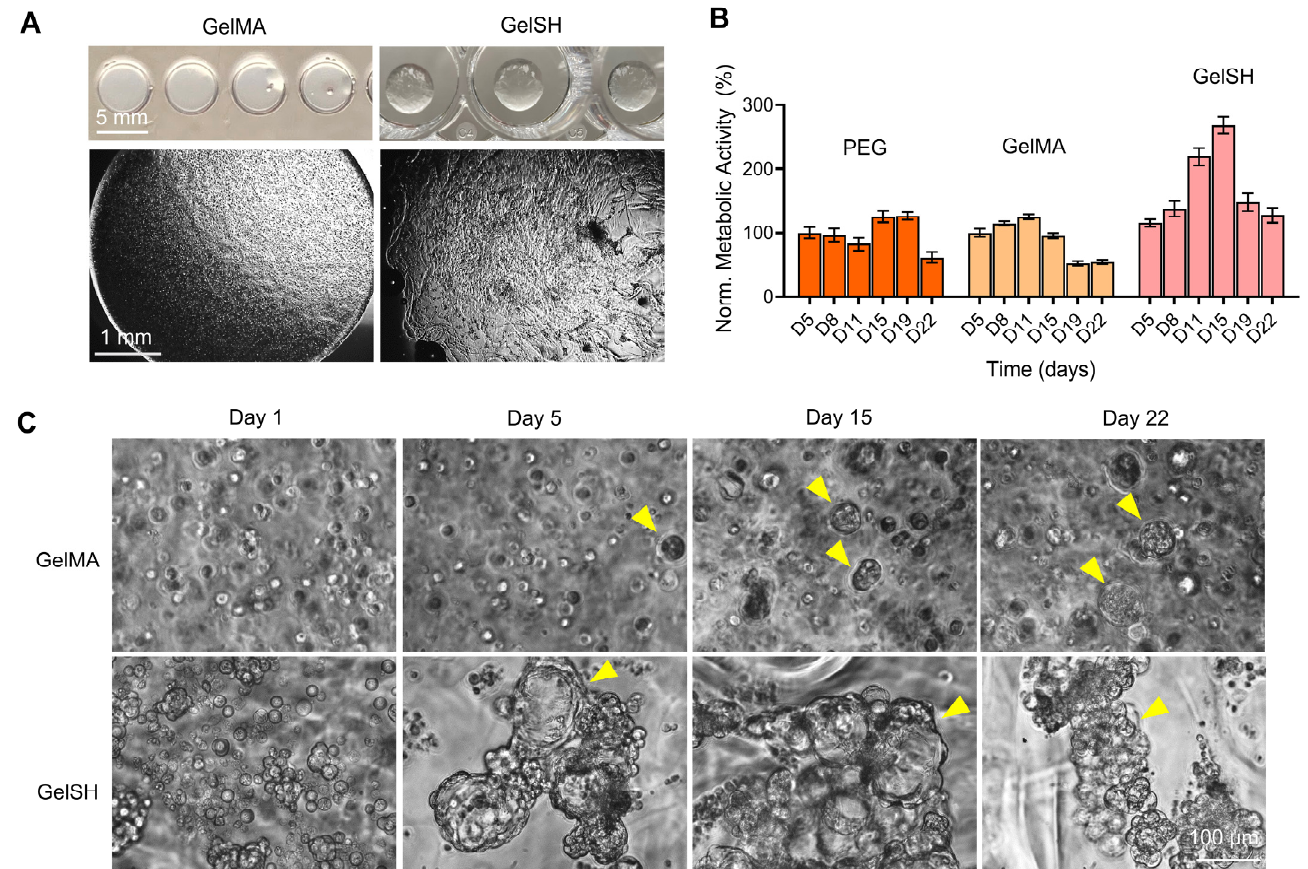
Figure 4. Effect of gel type on the growth and viability of breast cancer patient-derived organoids (BCa PDOs) for similar gel stiffness (3 kPa) up to 22 days of culture (P#03F). ( A ) Macroscopy and brightfield microscopy images of gelatin-based hydrogels; UV-crosslinked gelatin methacryloyl gels (GelMA) and click-crosslinked thiolated gelatin-based hydrogels (GelSH). ( B ) Metabolic activity of BCa PDOs over time, normalized to bioprinted PEG-(RGD + GFOGER + DYIGSR) group at Day 5. Means ± SEM shown, n = 4–16 technical replicates. ( C ) Brightfield images of cells in GelMA and GelSH gels over time, showing organoid formation (yellow arrows) after 5 days of culture for both gel types.